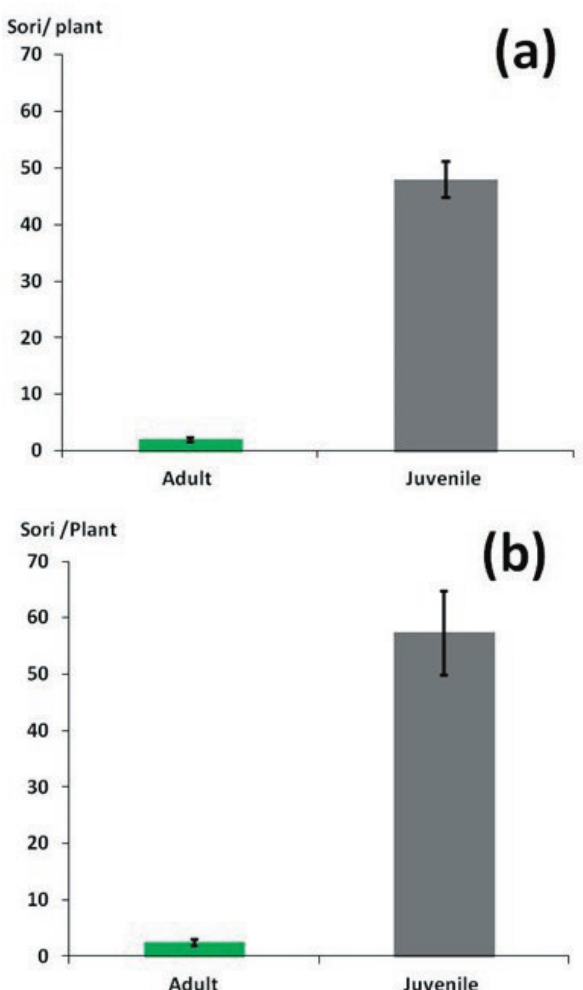
Figure 1. (a) Average numbers of Albugo candida sori per plant on Lunaria annua plants in 2017. (b) Average numbers of A. candida sori per plant on L. annua plants in